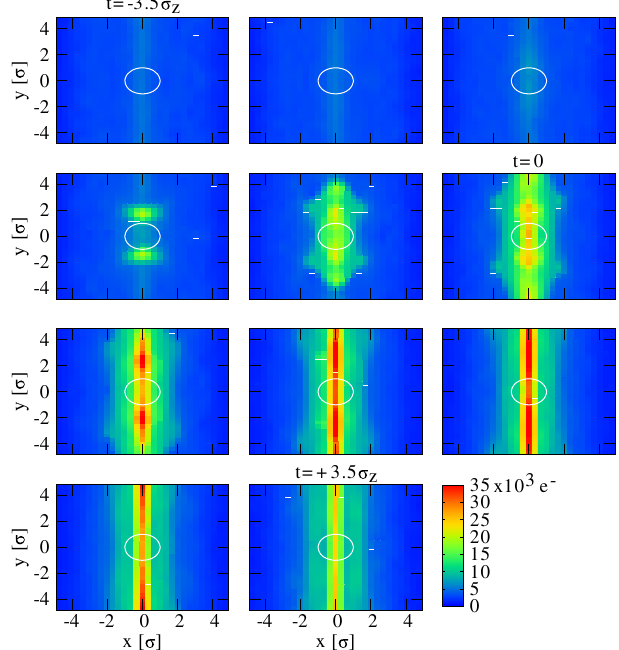
FIG. 22. Transverse charge distributions of the electron cloud in an 800-Gauss dipole field during the passage of the last bunch of the 30-bunch train at 0 . 7 mA = bunch at 2.1 GeV, in the central region ( (cid:2) 5 σ of the beam size) for 11 time slices spanning (cid:2) 3 . 5 σ z . The rms beam size is shown as a white circle. Time increases from left to right, top to bottom. The time between slices is 20 ps. (Beam energy is 2.1 GeV.)